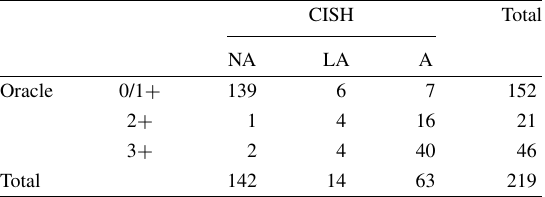
Concordance between fully automated monoclonal antibody-based Oracle HER2 staining and chromogenic in situ hybridization (CISH) in 219 breast cancers CISH